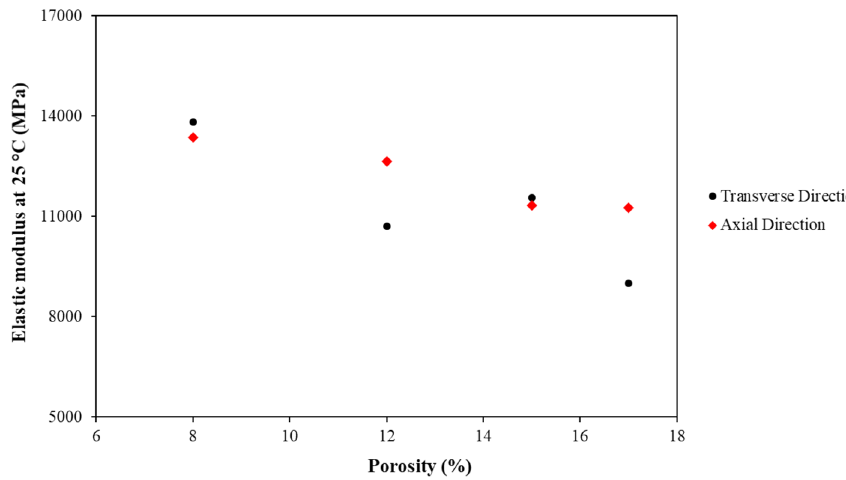
Fig. 9 Effect of specimen preparation direction, either transverse or axial based on the orientation of the original billets, on graphite elastic modulus at room